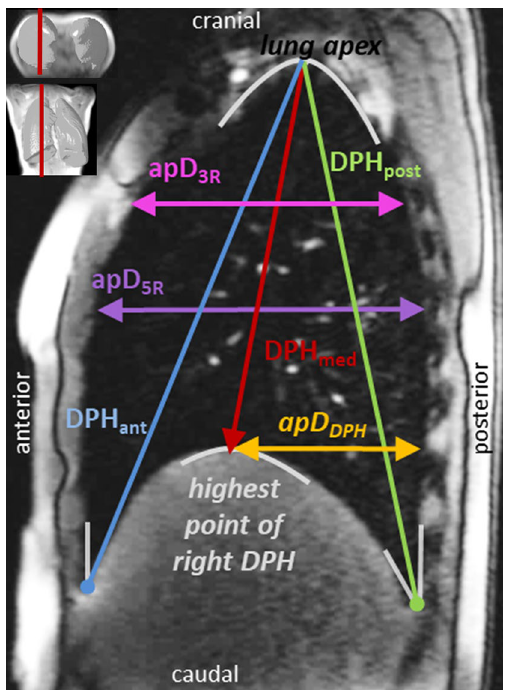
Figure 2. Measured distances in a sagittal plane of the right lung and their definition according to anatomical landmarks. Start and endpoints of measured distances according to anatomical landmarks (start–end). For details description see also Supplementary Table S3. DPH ant = distance: anterior diaphragm–lung apex, DPH med = distance: highest point of the diaphragm–lung apex, DPH post = distance: posterior diaphragm–lung apex, apD 3R = horizontal anterior–posterior lung diameter: start of lung tissue–end of lung tissue at the height of the 3th rib, apD 5R = horizontal anterior–posterior lung diameter: start of lung tissue–end of lung tissue at the height of the 5th rib, apD DPH = horizontal anterior–posterior diameter: highest point of the diaphragm cupola– end of lung